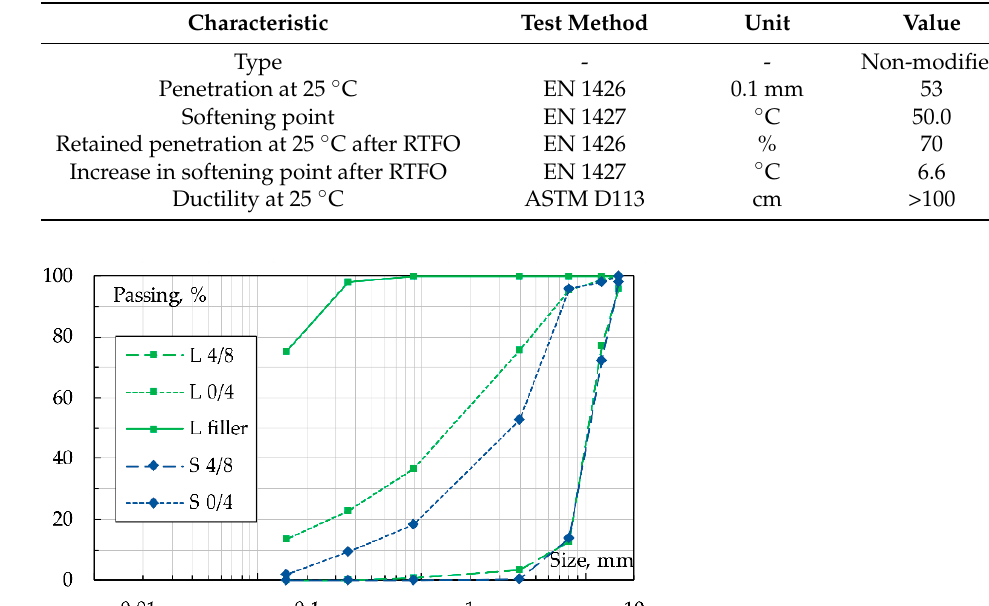
Figure 1. Global research framework and experimental plan [31,32].